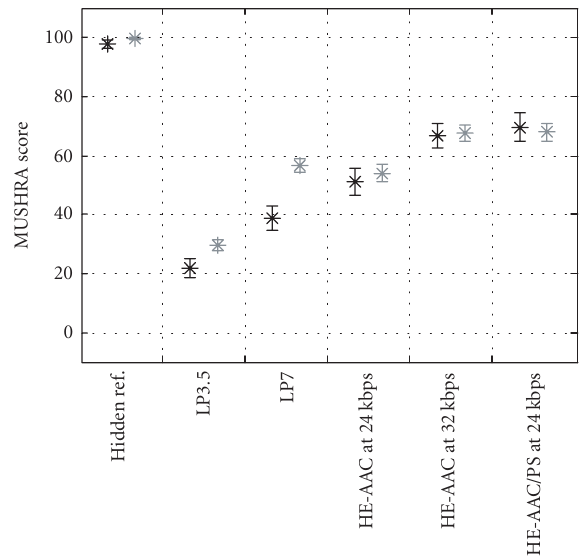
Figure 12: MUSHRA listening test results for two sites (black and gray symbols) showing mean grading and 95% confidence